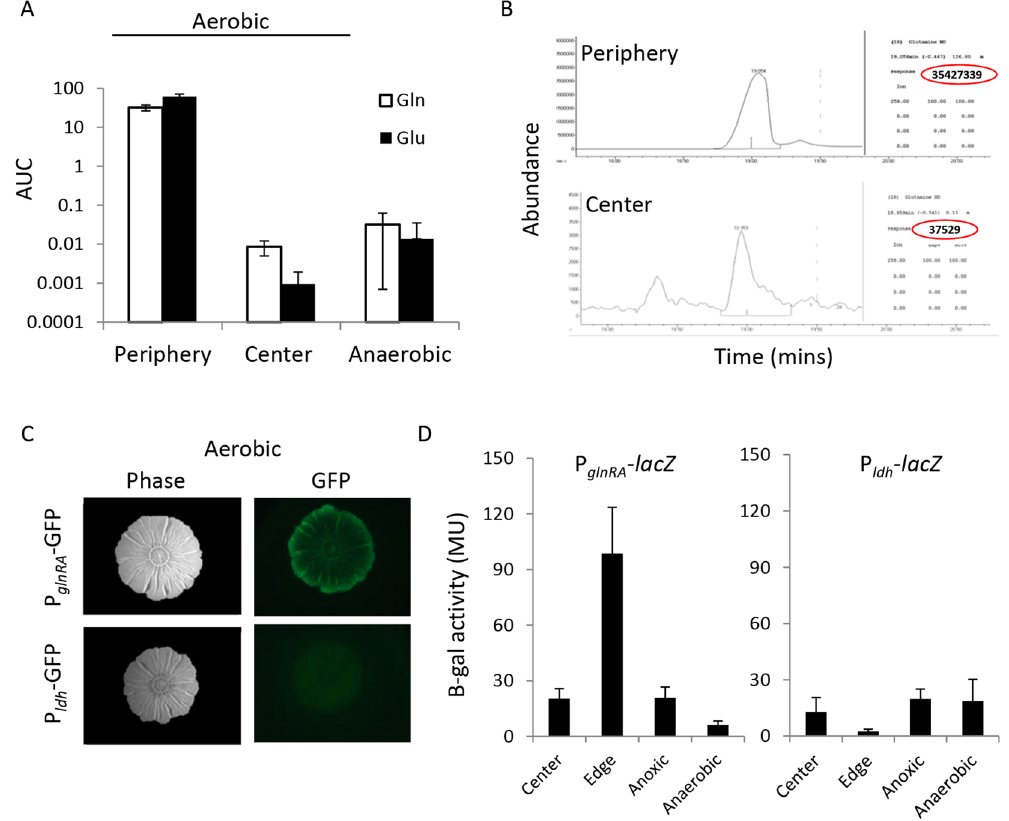
Figure 3. Spatial distribution of glutamate utilization within biofilms. ( A ) GC-MS analysis results for glutamine and glutamate levels in biofilm cells collected from different regions of the biofilms. The results are presented as averages and standard deviations of a representative experiment performed in quadruplicates, out of three independent biological repeats. The periphery samples for both metabolites differed from the anaerobic and center samples by a p–value < 0.0001. Anaerobic and center samples were not significantly different from each other (p-value > 0.5). ( B ) Representative measurements of MS ion intensities for glutamine in the periphery and in the center of B . subtilis biofilm colonies showing three order of magnitude higher levels of glutamine in the periphery (red circles point to the relevant specific values). ( C ) Biofilm strains carrying P glnR -gfp (the upstream promoter of the operon encoding glutamine synthase) or P ldh -gfp constructs (the promoter of lactate dehydrogenase) following 72 hours of growth on standard biofilm-inducing medium with nitrate under aerobic conditions. Images were taken with a stereo microscope using white light (left) or fluorescence (right). Shown is a representative experiment performed in duplicates, out of at least three independent repeats. ( D ) Expression of P glnRA - lacZ and P ldh - lacZ . Cells were grown on MSgg as described in Materials and Methods for 48 h. After 48 h, colonies carrying either P glnRA - lacZ or P ldh - lacZ were harvested, and LacZ activity was measured. The results are the average for three independent experiments performed with triplicates. Errors bars represent the corresponding standard deviations. For both reporters, the edge and the center were significantly different (P-value <